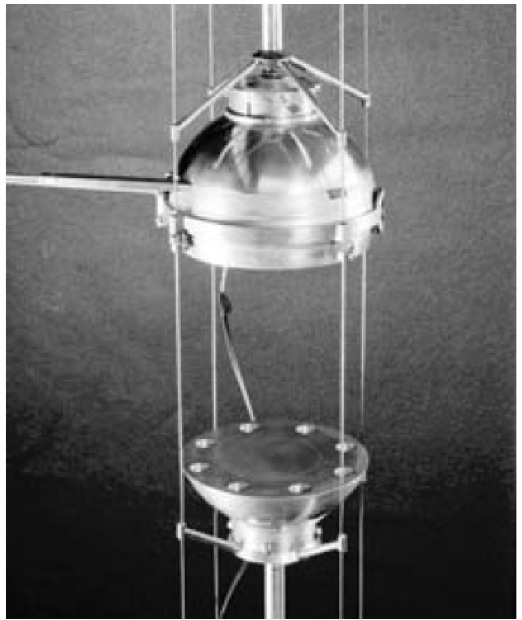
Fig. 2. The Jezebel 239 Pu critical assembly shown above is widely used by nuclear data evaluators to constrain their evaluations of neutron-induced reactions on 239 Pu, creating hidden correlations between different quantities such as v , PFNS and s f , as discussed by Bauge and Rochman [1] and Rochman et al.